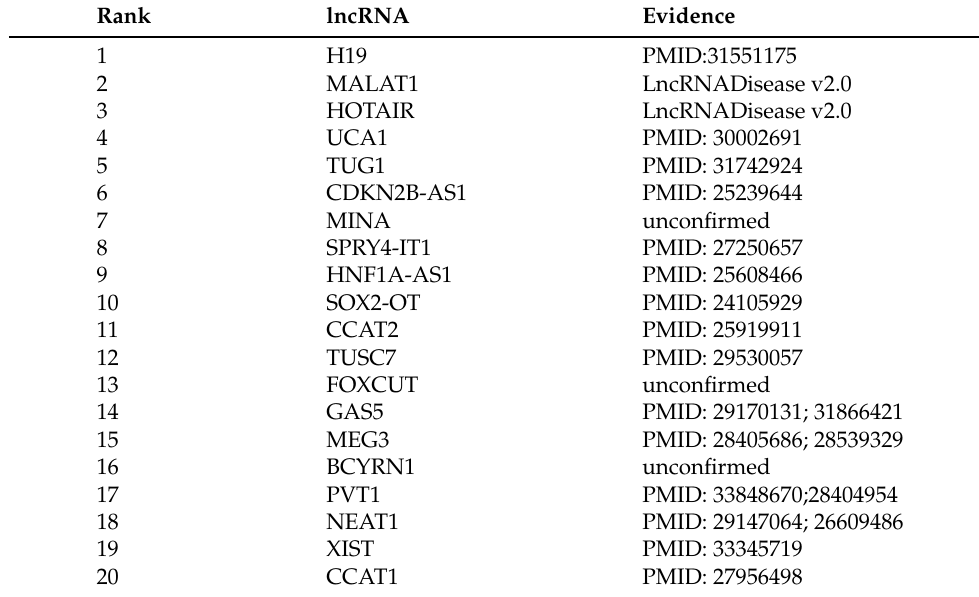
Table 3. Top 20 identified lncRNAs for esophageal squamous cell